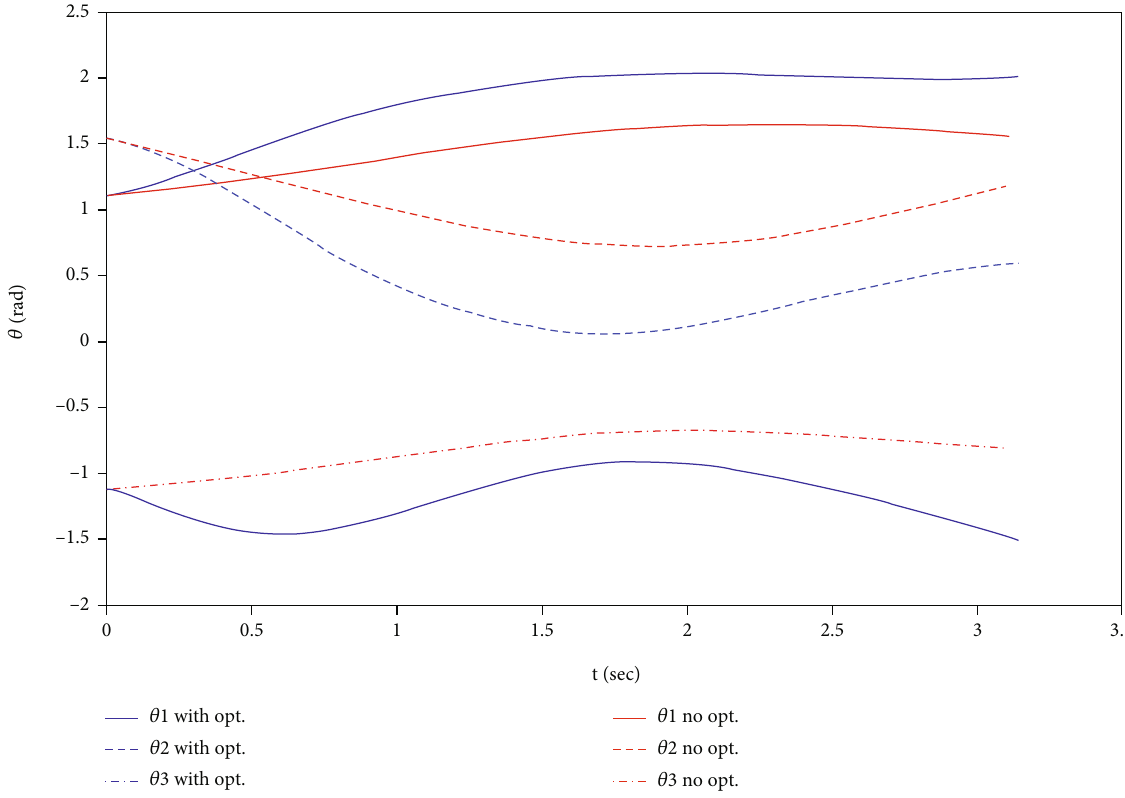
Figure 6: The displacement of each joint during